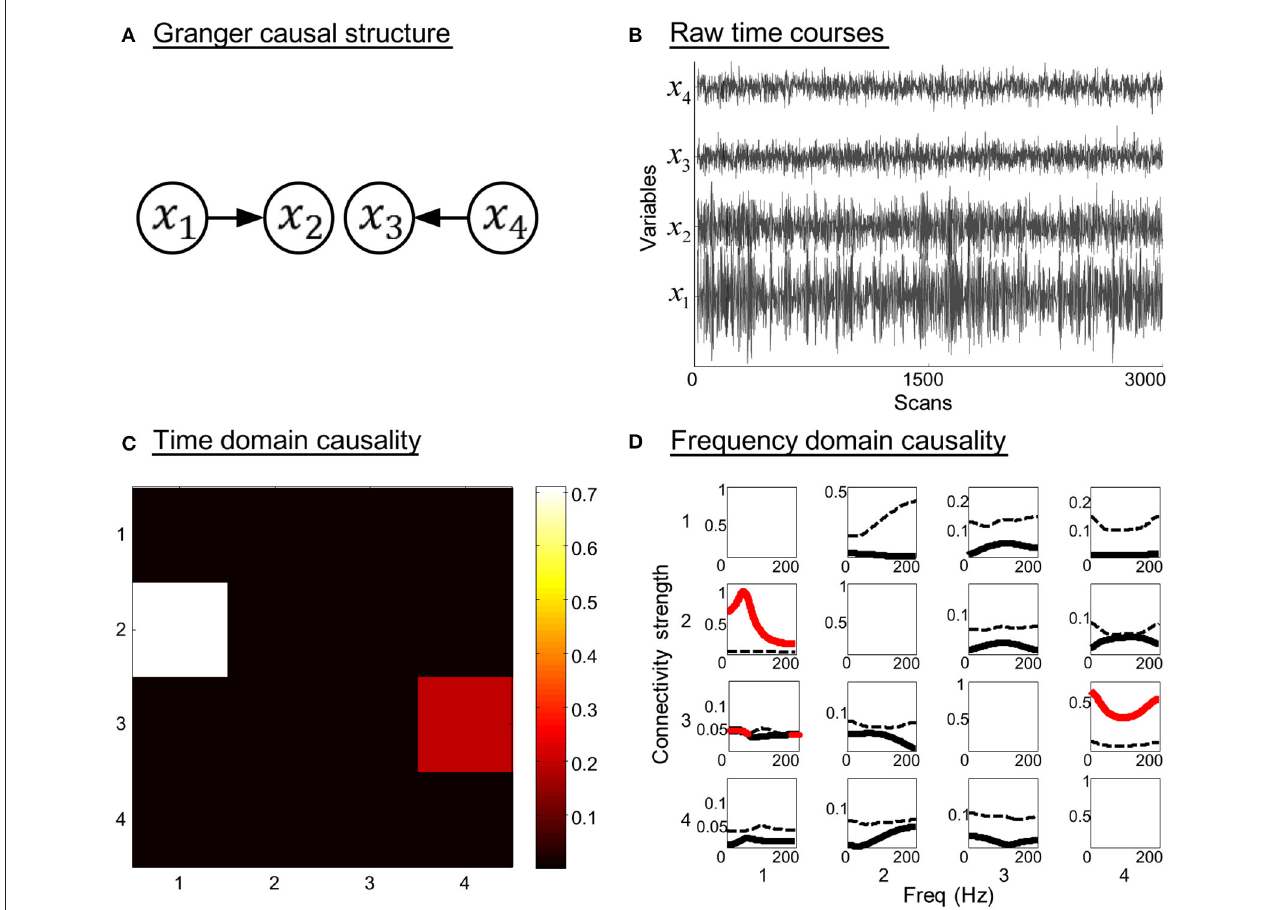
FIGURE 2 | Simulation results of toy model 1. (A) Granger causal structure of the variables. (B) Raw time courses of the variables. (C) The colormap of partial Granger causality values in time domain analysis. (D) The spectrum of significance thresholds (black dotted line) and partial directed coherence (PDC) values (black solid line, values greater than the thresholds are highlighted in red) in frequency domain analysis. Note: in (C,D) the direction of causality is from column to